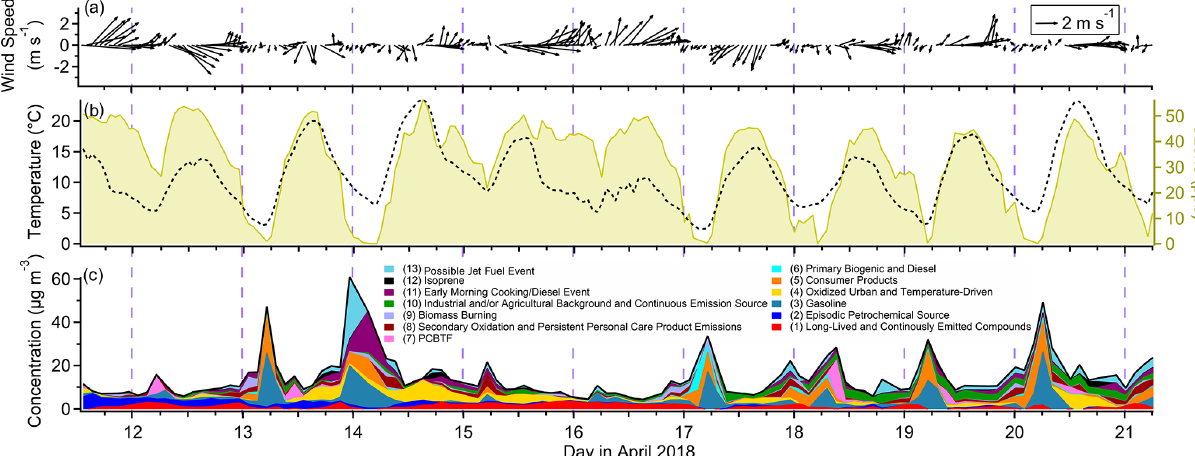
Figure 3. (a) Time series of wind speed and direction, (b) time series of temperature (left axis) and ozone (right axis) measured at the Bay Area Air Quality Management District monitoring site, and (c) all factor timelines stacked. Date labels are at